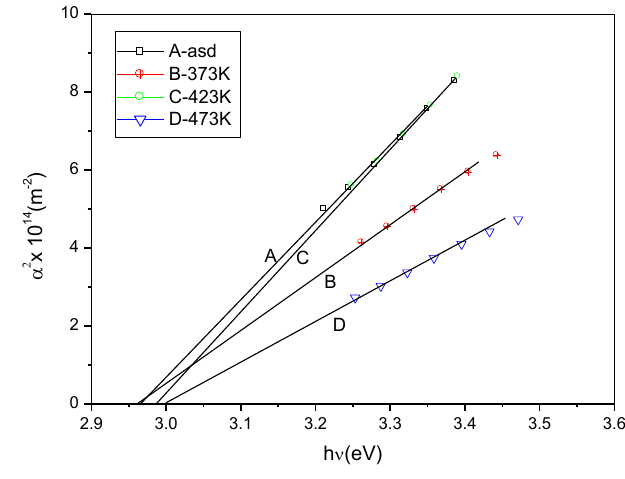
Figure 3 . Plot of α 2 versus photon energy hν Cl at 373,423 and 473K in